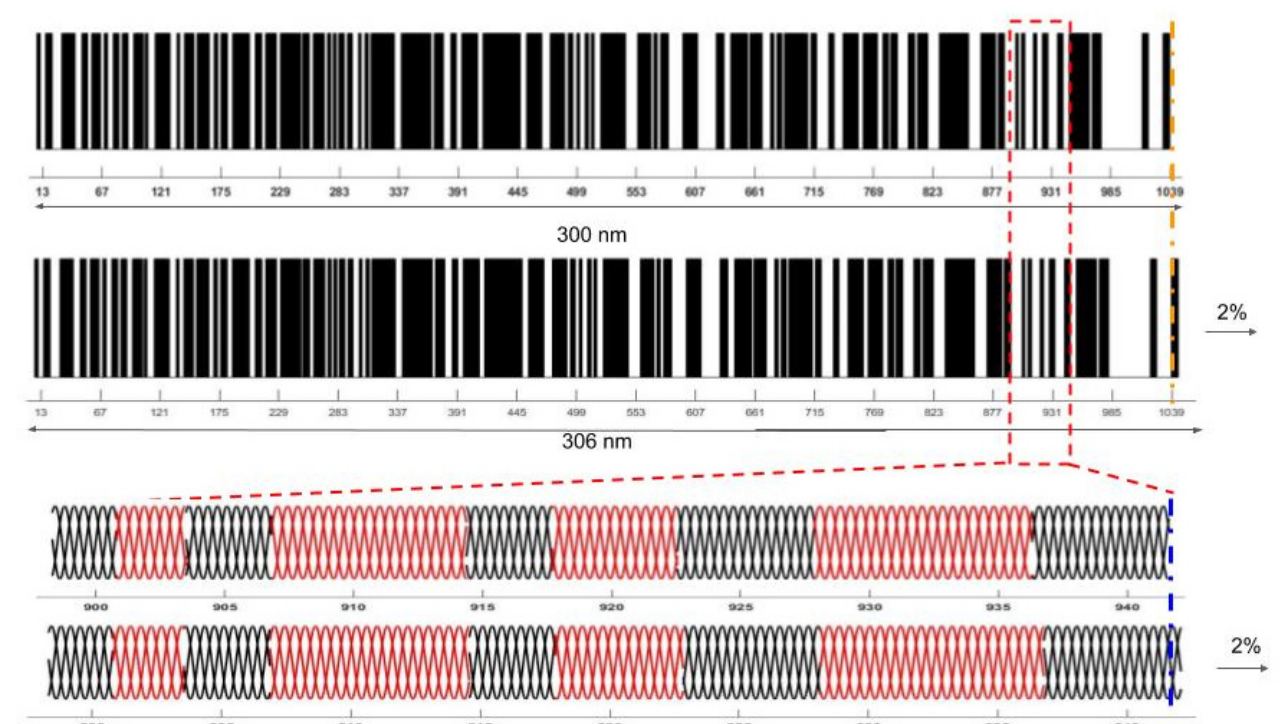
Figure 11. Diagram of energy storage in the collagen molecule via stretching of the flexible regions. When collagen triple helices are stretched, the flexible regions elongate and become more rigid by adopting a conformation more like the rigid regions. The diagram at the top shows the bar code depicting the collagen triple helix with rigid (black) and flexible (white) regions before and after stretching 2%. The diagram below the bar code shows that the red flexible regions deform axially while the black rigid regions are fixed during stretching. The stretching of the flexible regions lowers the entropy of the triple helix. Energy is stored by raising the free energy of the system during stretching while lowering the entropy. That energy is returned reversibly returned to the surrounding tissues when the load is removed from the collagen fibers.